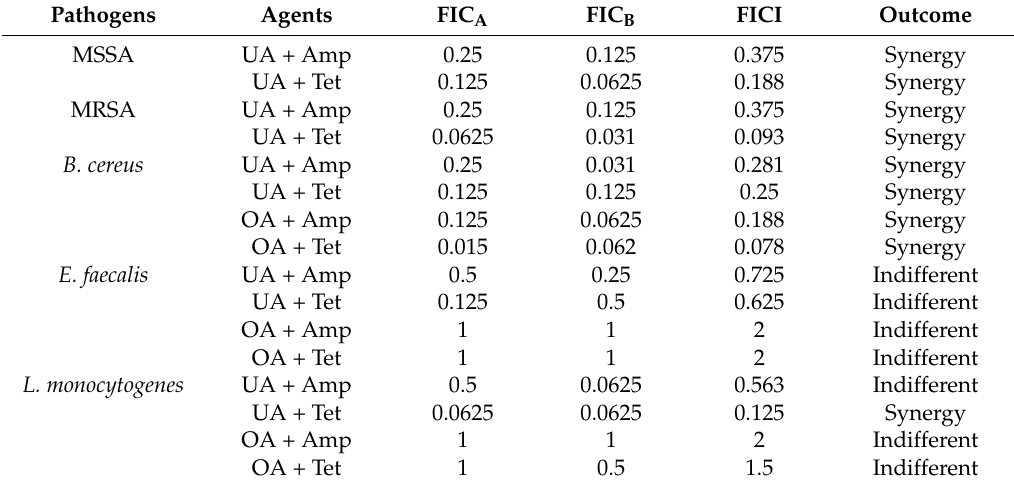
Table 3. Fractional inhibitory concentration indices (FICIs) calculated based on checkerboard assay indicating the interaction of triterpenoids with antibiotics against Gram-positive